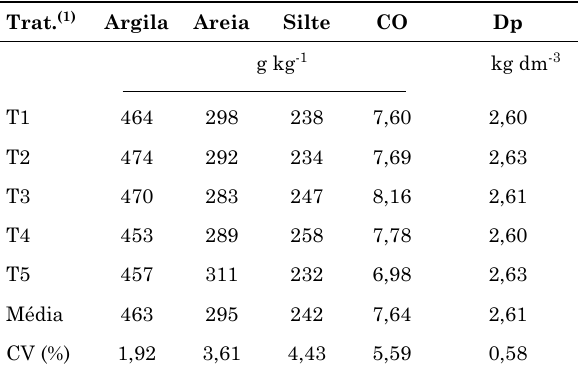
construído cultivado com Cynodon dactilon ; T4: solo construído cultivado com Urochloa brizantha ; e T5: solo construído sem a implantação de plantas de